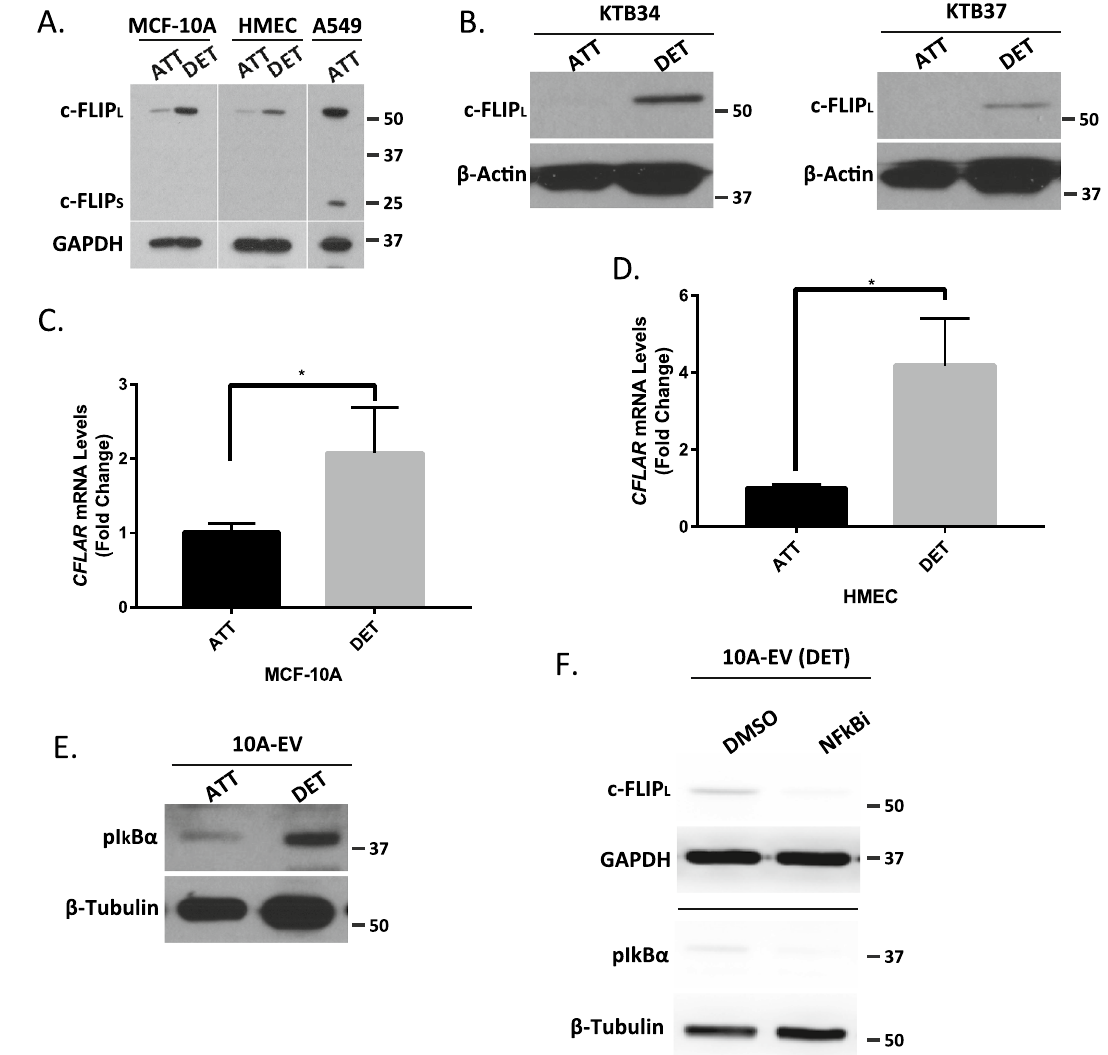
Figure 2. ECM-detachment triggers c-FLIP L expression in non-cancerous epithelial cells. ( A ) Measurement of c-FLIP L protein levels in MCF-10A cells in attachment (ATT) and detachment (DET) conditions using western blot. A549 cells are included as a positive control for c-FLIP S . ( B ) Measurement of c-FLIP L protein levels in KTB34 cells (left) and KTB37 cells (right) after cells were grown in attachment versus detachment conditions for 24 h. ( C , D ) Measurement of c-FLIP L transcript levels ( CFLAR ) using RT qPCR in ( C ) MCF-10A cells and ( D ) HMEC cells. ( E ) Measurement of NFkB signaling in 10A-EV cells by blotting for phopho-IκBα in attachment versus detachment conditions. ( F ) Measurement of the changes in c-FLIP L protein levels following inhibition of NFκB activity using 5 uM BAY-117082. Graphs show representative data from a minimum of three biological replicates and all western blotting experiments were independently repeated a minimum of three times with similar results. Statistical significance was determined using Student’s two-tailed t test. Error bars show standard